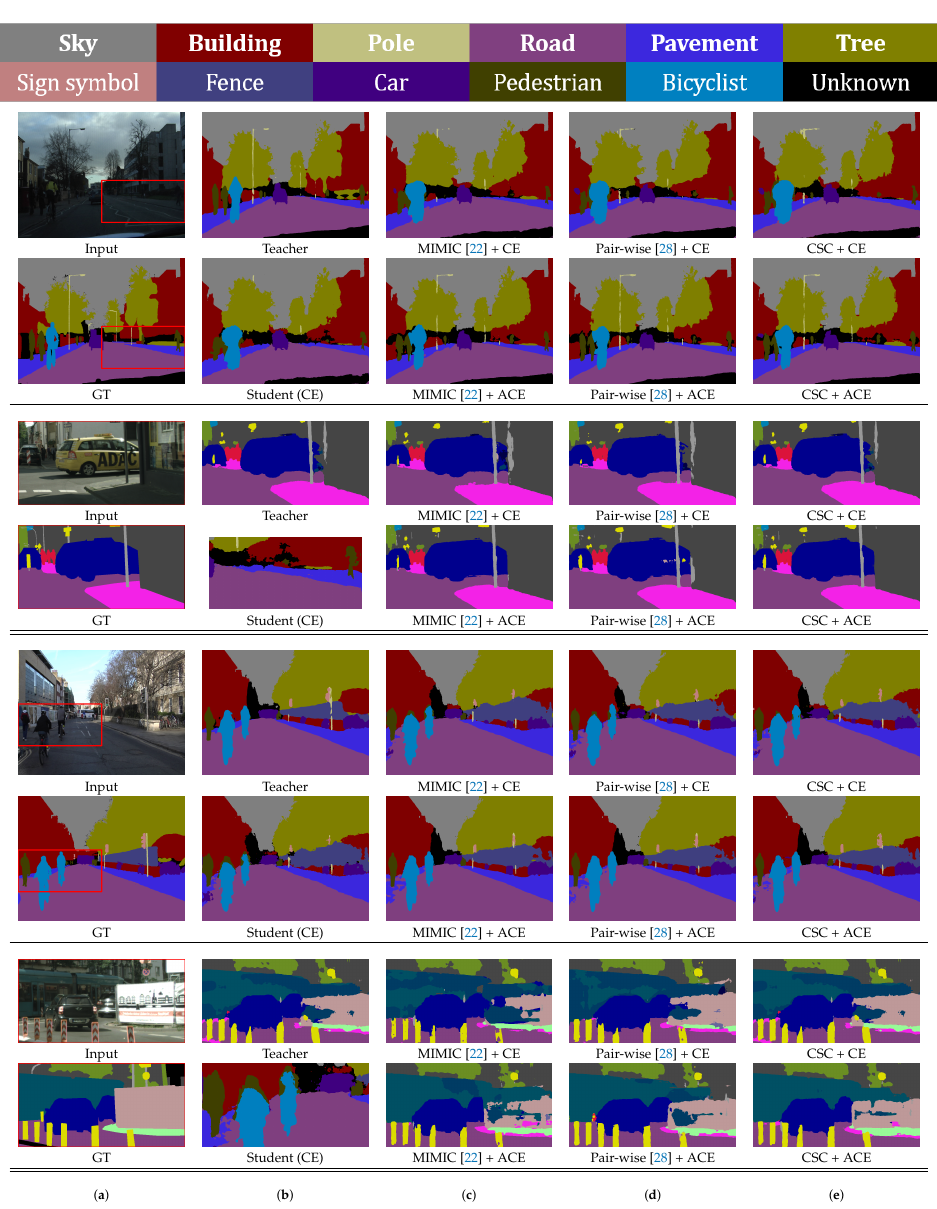
Figure 8. Qualitative comparison of various methods on the Camvid validation and test set. ( a ) Input and ground-truth(GT) images. ( b ) Teacher and student (CE) networks. ( c ) MIMIC [22]. ( d ) Pair-wise [28]. ( e ) Proposed